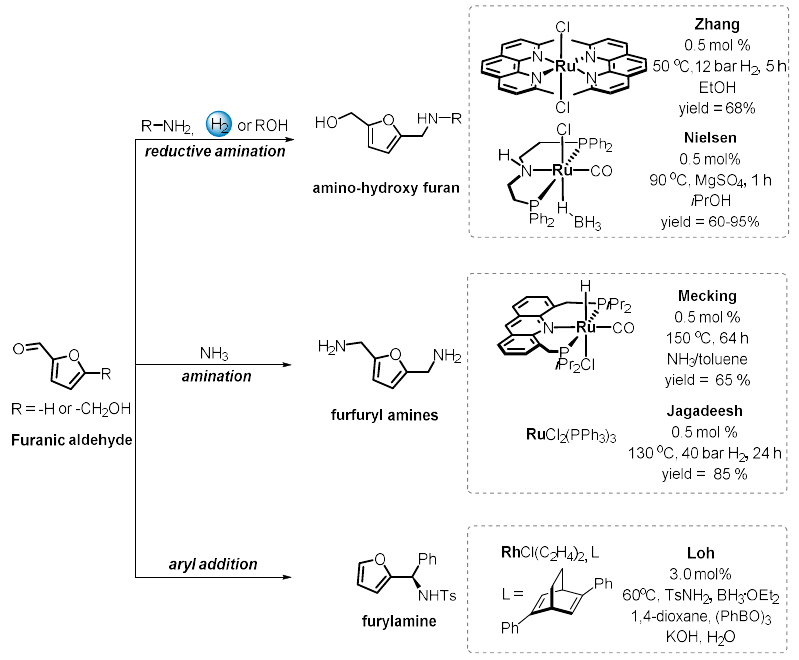
Figure 9. Synthesis of N -containing building blocks via reductive amination of furanics. N-Substituted 5-(hydroxymethyl)-2-furfuryl amines have a wide application in phar- maceutical industry, e.g., for the production of calcium antagonists, muscarinic agonists, cholinergic agents, and carcinogenesis inhibitors [195]. These structures are